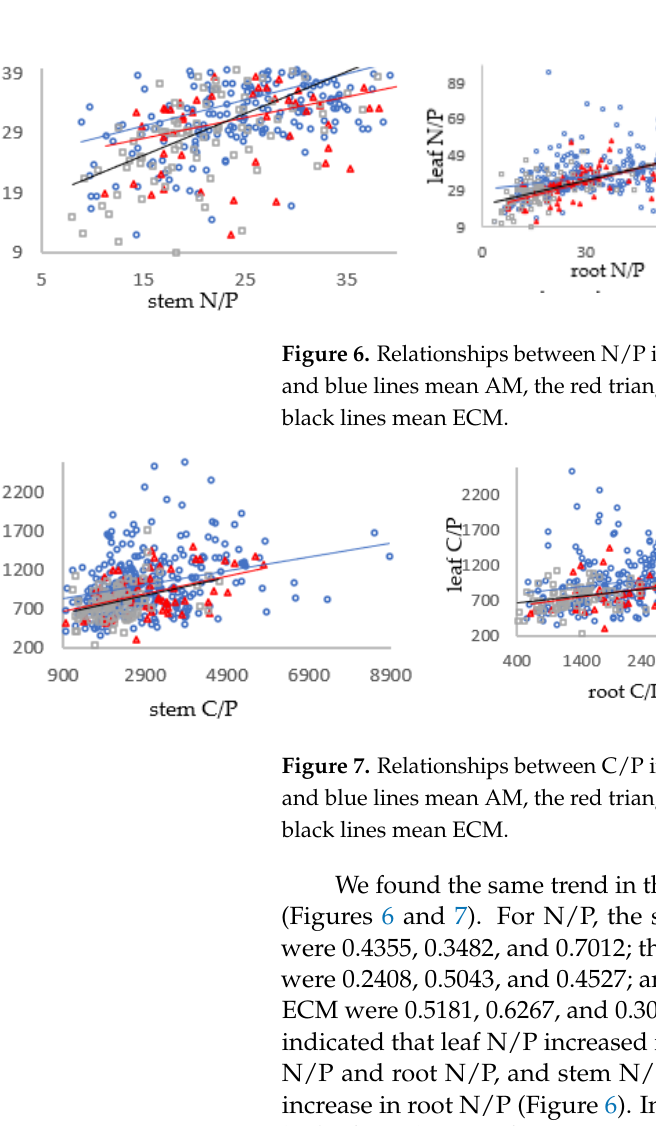
Figure 5. Relationships between C/N in shrub organs for different mycorrhizal types. The blue cy- cles and blue lines mean AM, the red triangles and red lines mean AM + ECM, and the gray squares and black lines mean ECM.